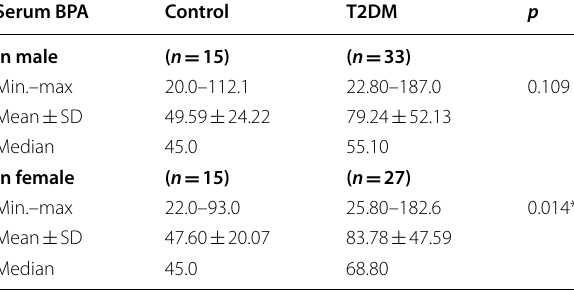
p p -value for comparing between the studied groups * Statistically significant at p